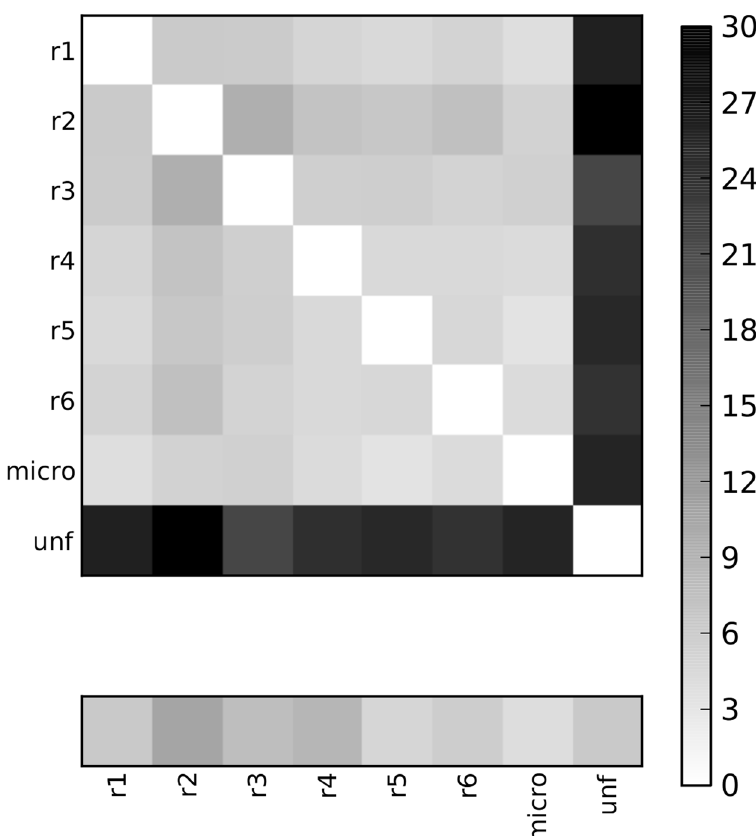
Figure 2. Comparison of LMI matrices describing correlated motions. The Frobenius norms between average LMI matrices calculated from different replicates of the same target protein are reported. An average LMI matrix achieved from an unfolding simulation at 500K of the same protein is used as a control. The example of Dri FREE simulations is reported for sake of clarity. Similar results with even lower Frobenius norms were obtained for ARID3A FREE replicates (average Frobenius norm of 5). Average LMI were calculated with five-ns time-windows, as explained in Materials and Methods. The box on the bottom shows the values of Frobenius when the two halves of each replicate are compared to use as a baseline in the comparison.